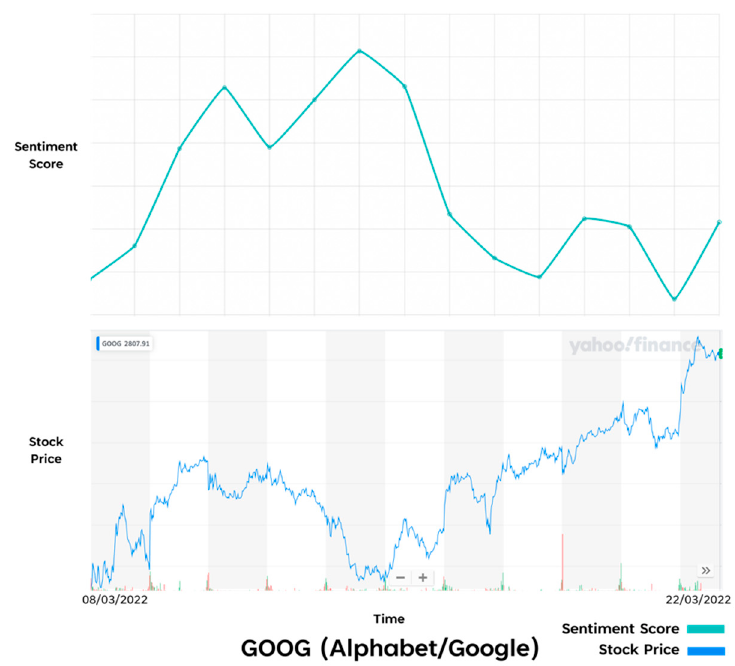
Figure 18. Comparison of Prototype results and Real-Life results—GOOG.